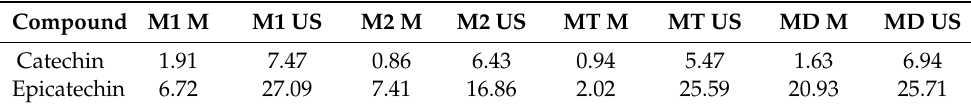
Table 2. Polyphenolic compounds identified and semiquantified in the extracts (mg compound/g vegetal